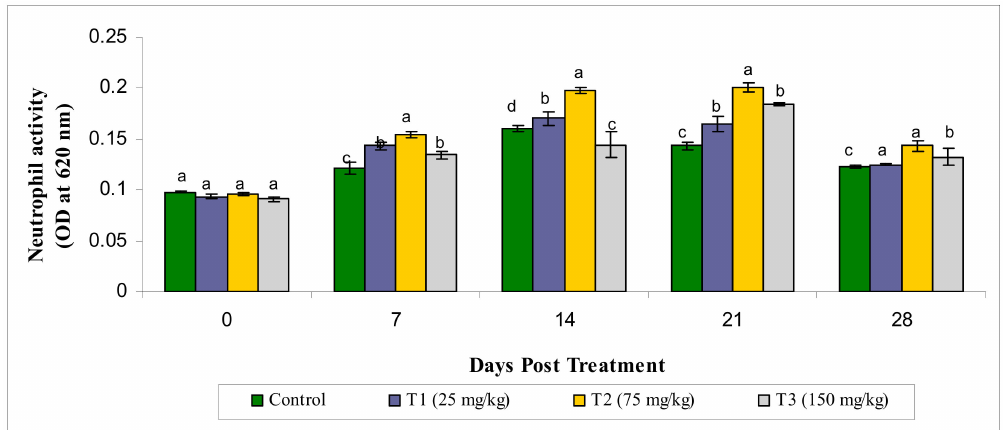
Figure 1. Neutrophil activity (OD at 620 nm) under di ff erent treatments administered with various levels of methanol extract of Chaetomorpha antennina in Labeo rohita during post treatment days (values are mean ± SE). a,b,c,d Mean values with di ff erent superscripts considered as statistically di ff erent ( p < 0.05); n = 6 for each treatment